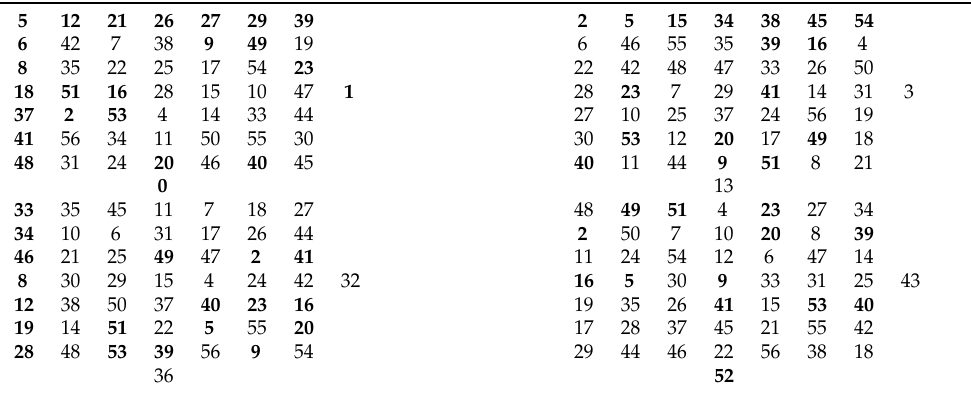
Table 1. The Singer representation of